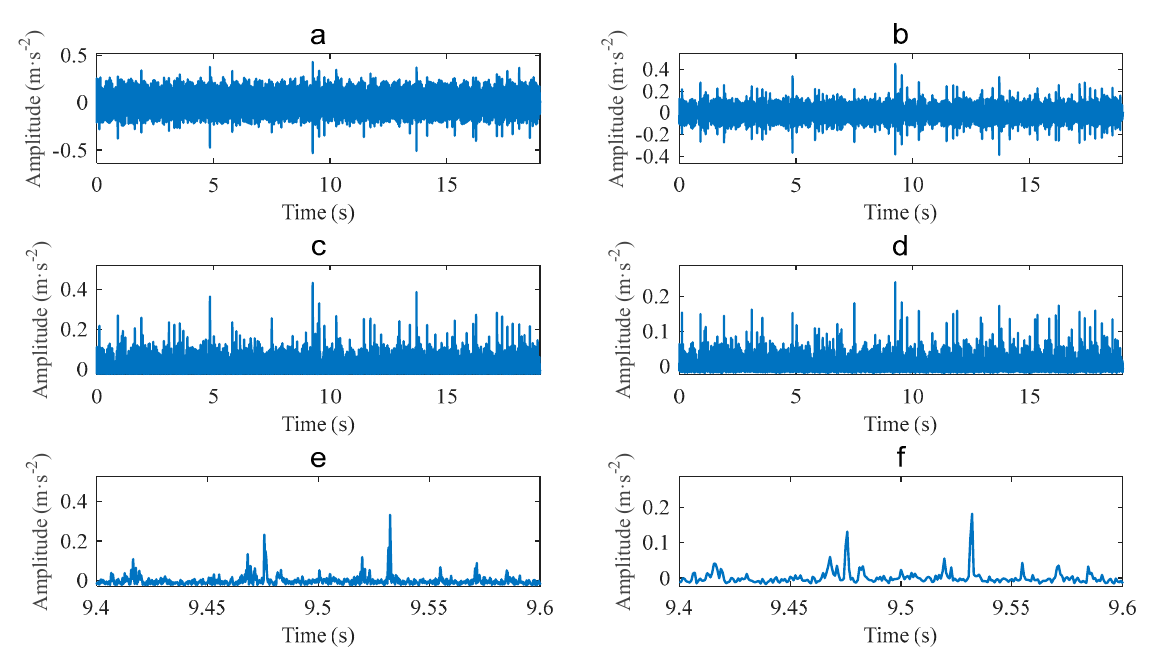
11 of 15 Figure 9. Case 1 for outer race defect: Amplitude spectra of IMFs obtained from an original signal segment that has the same samples as the compressed signal. 3.2. Validation for Inner Race Defect Case